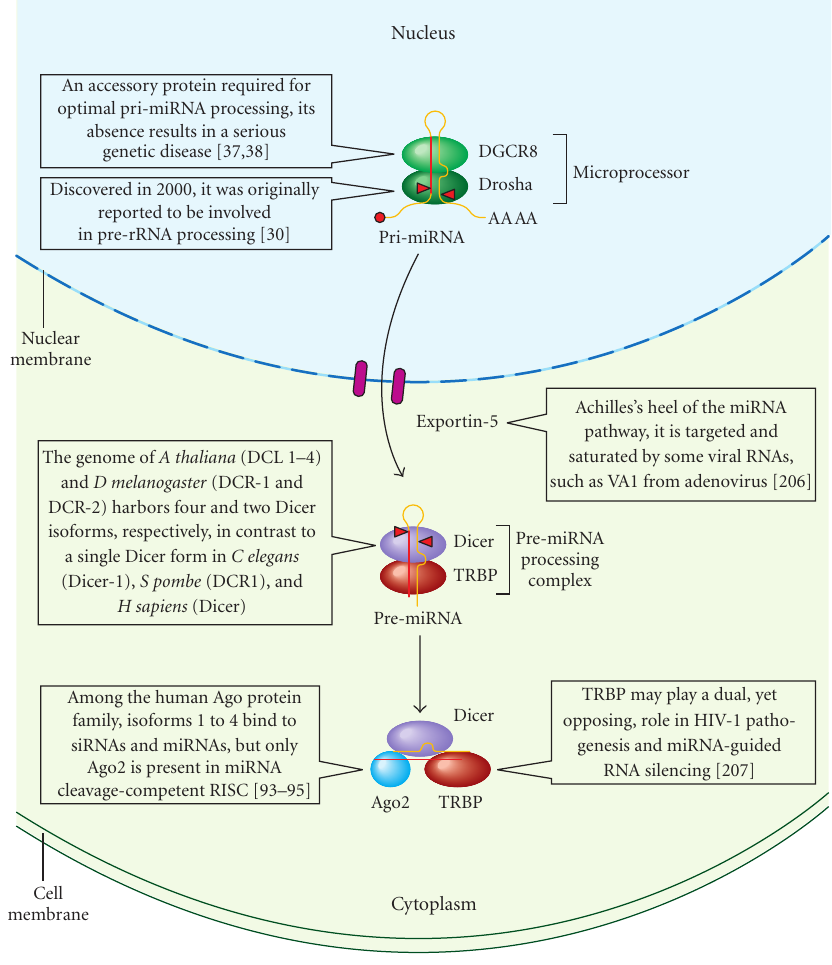
Figure 2: Some peculiarities of the major protein components of the microRNA-guided RNA